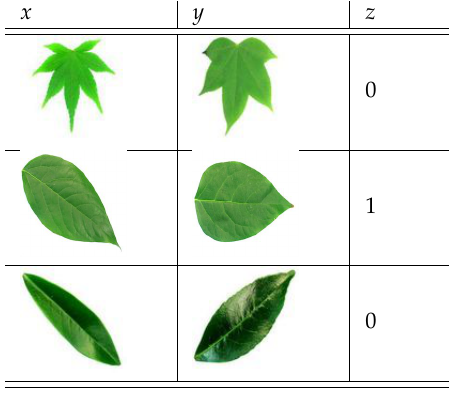
Figure 6. Example of 3-tuples used for the CSN